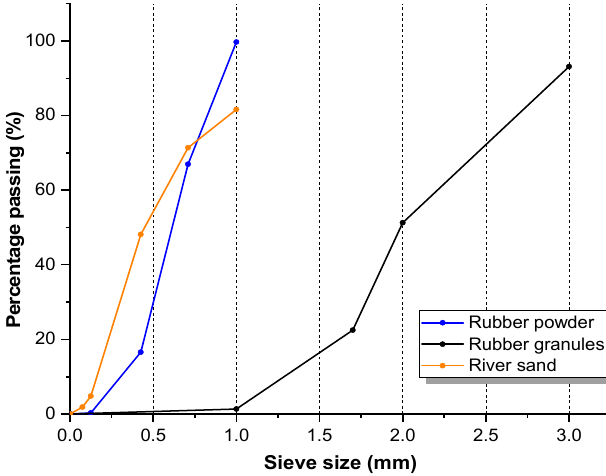
Figure 2. Particle size distribution of RP, RG, and river sand.